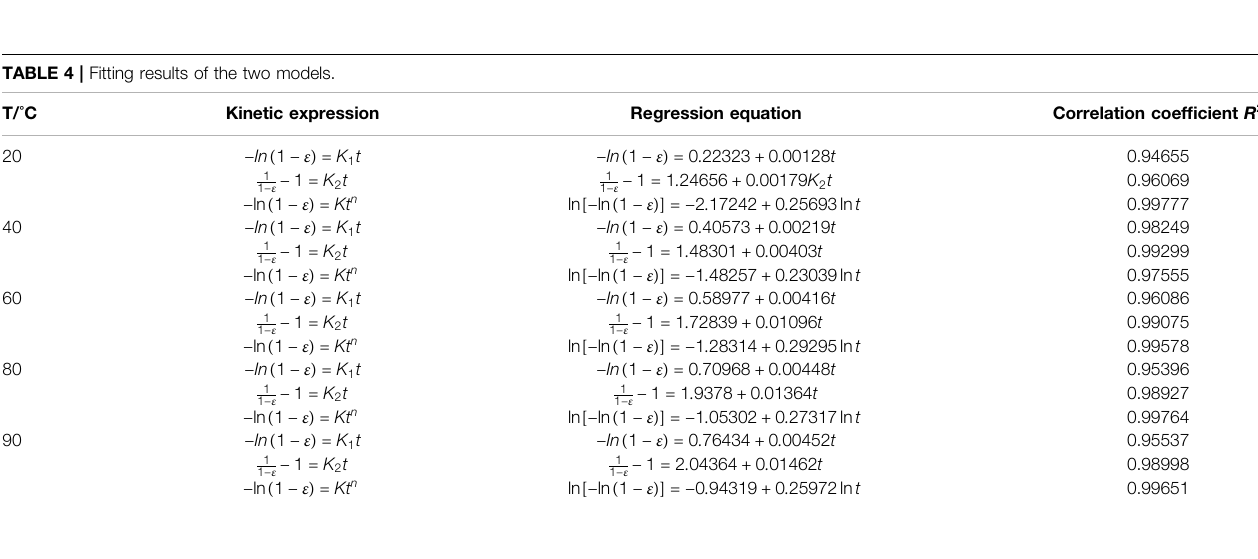
TABLE 4 | Fitting results of the two